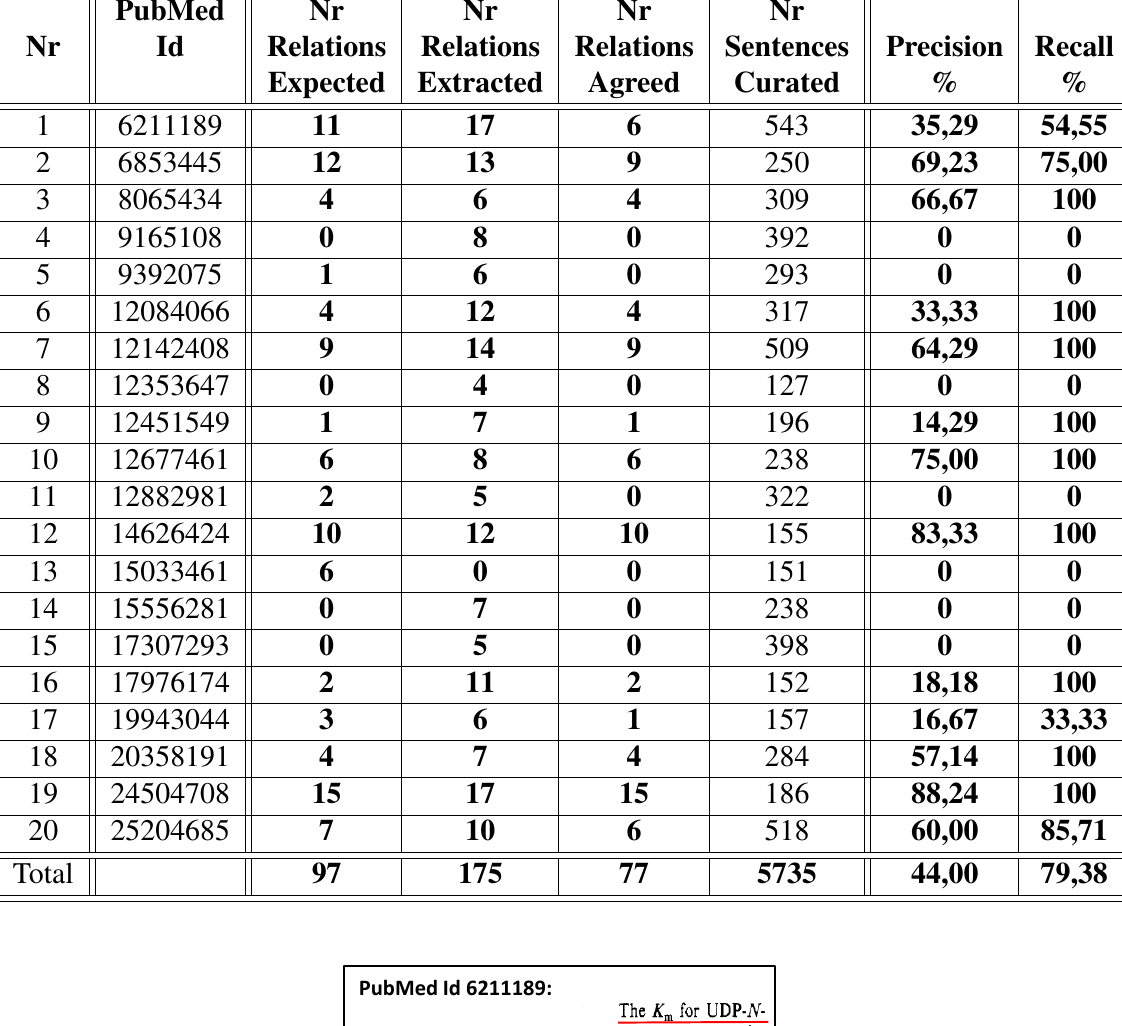
Table 4: Results for the 20 papers submitted to the pipeline (manual curation vs KineticRE).